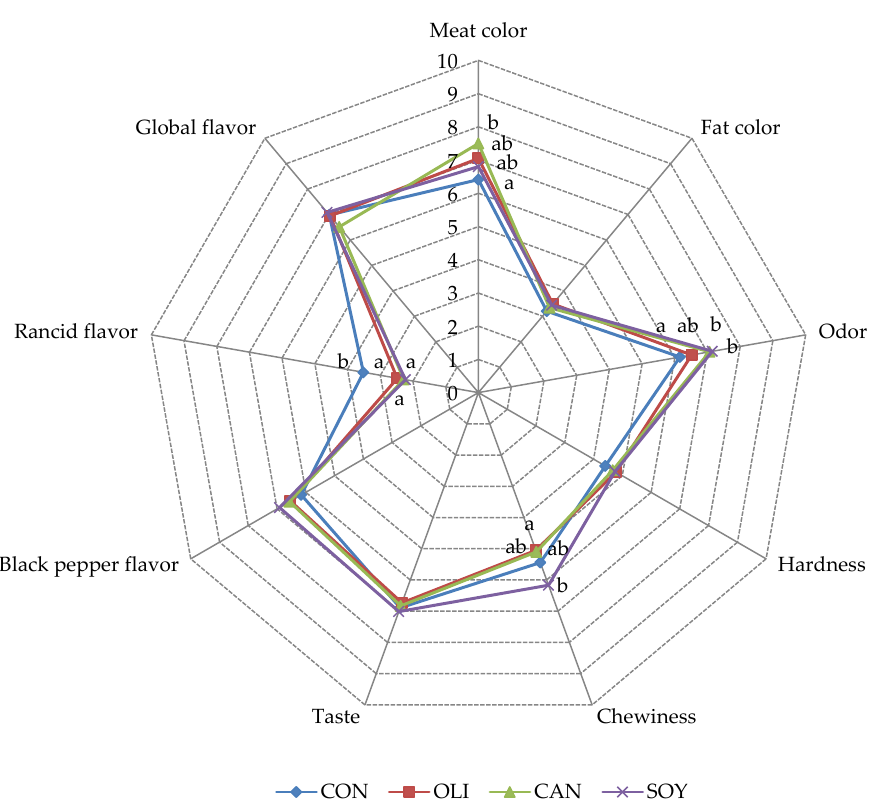
Figure 1. Effect of pork fat replacement by vegetable oil emulsion on sensory characteristics of dry-fermented deer sausages. a,b Mean values in the same row (corresponding to the same parameter) not followed by a common letter differ significantly ( p < 0.05; Duncan test); Treatments: CON: sausages prepared 100% pork fat; OLI: sausages reformulated with 50% of pork fat replaced by olive oil; CAN: sausages reformulated with 50% of pork fat replaced by canola oil; SOY: sausages reformulated with 50% of pork fat replaced by soy oil.